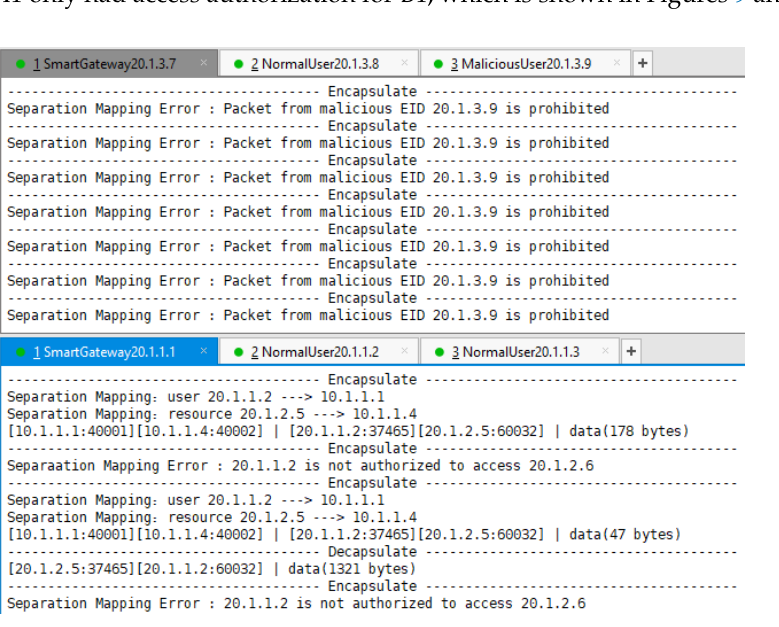
Figure 14. SG C and SG A perform the separation mapping